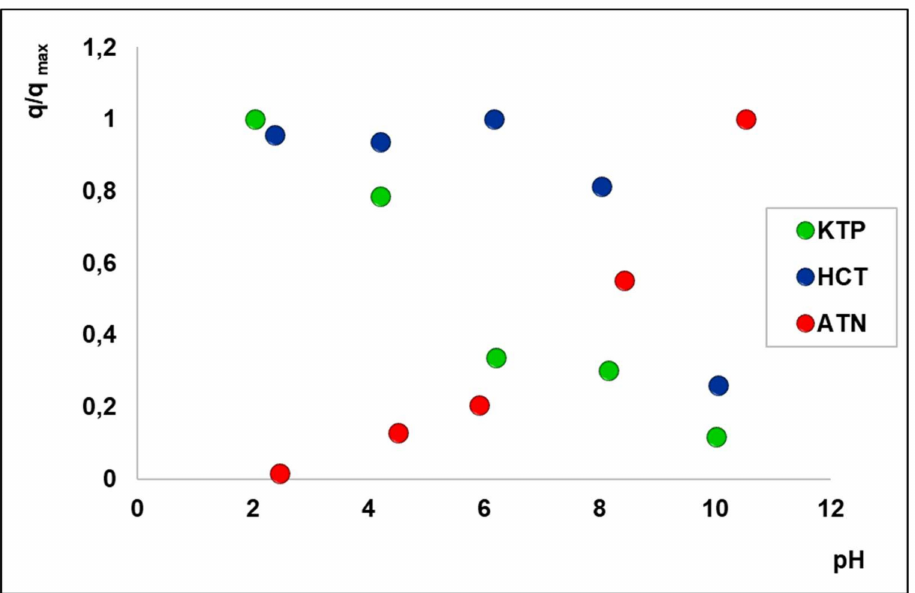
Figure 4. Normalized adsorbed amount (q / q max ) on Y200 of KTP (green), HCT (blue), and ATN (red) vs.